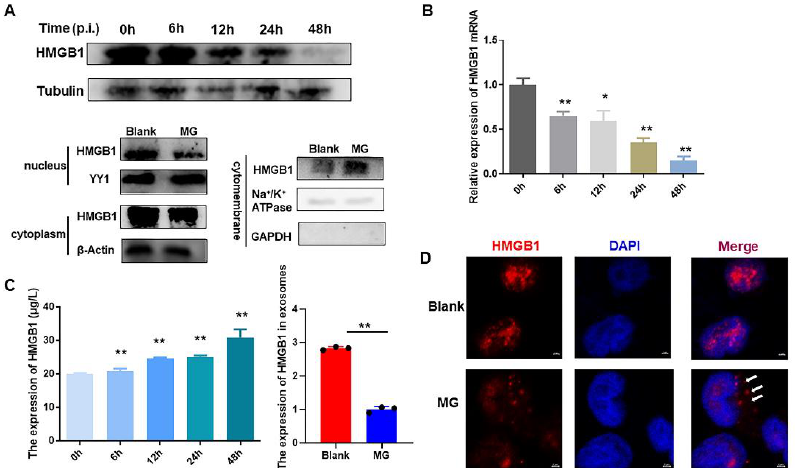
Figure 1. MG infection induces the secretion of HMGB1 in HD-11 cells. ( A ) The protein expression of HMGB1 was detected by WB. Tubulin, YY1, β -actin, or Na+/K+ ATPase are considered as the loading control. In addition, GAPDH was shown as the negative control of membrane protein. ( B ) The mRNA expression of HMGB1 HD-11 cells. GAPDH was used for normalization (n = 4). ( C ) Left: HMGB1 levels in the supernatant were measured by HMGB1 Elisa kit (n = 4). Right: The expression of HMGB1 was detected in the exosomes derived from MG-infected cells (n = 3). ( D ) Confocal images of HMGB1 (red) and DAPI (bule) in HD-11 cells. White arrows: membrane-localized HMGB1 (scale bar, 2 µm). * p < 0.05 and ** p < 0.01 show statistically significant difference compared to the 0 h group. Black dots in bar graph represent datasets from independent experiments.